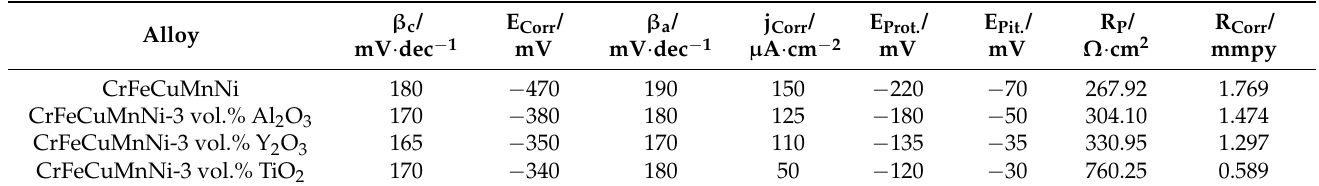
Table 3. Corrosion parameters obtained from the potentiodynamic cyclic polarization